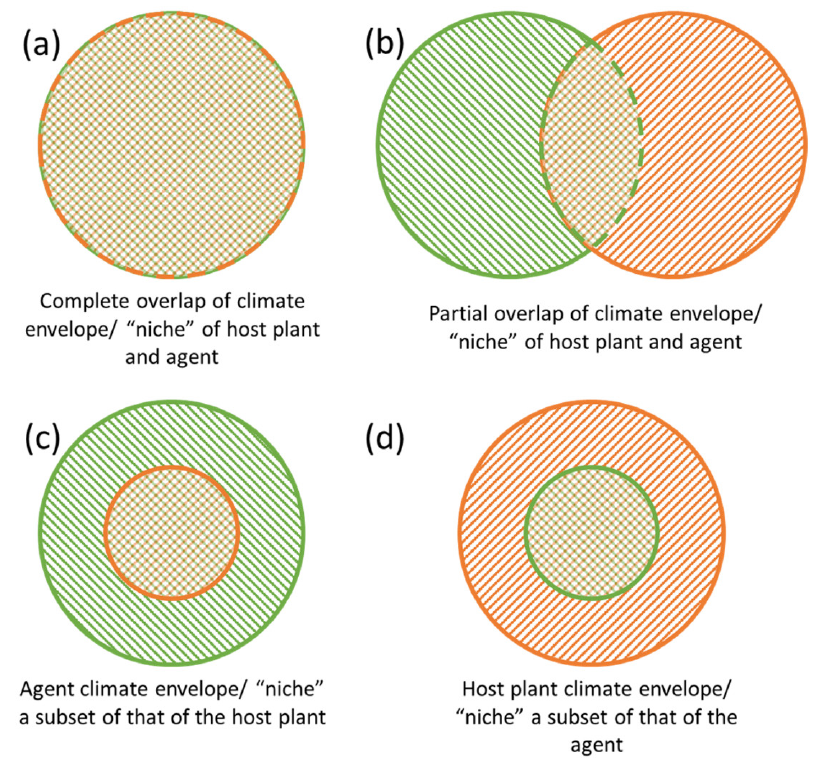
Figure 1. The four potential climate envelope overlap scenarios. In ( a , d ), there are minimal chances for climatic mismatches causing breakdown of biological control in the invaded range. In ( b , c ), opportunities for climatic mismatches in the invaded ranges result in only partial biological control across the invaded range. Green pattern = host plant; orange pattern = biological control agent.